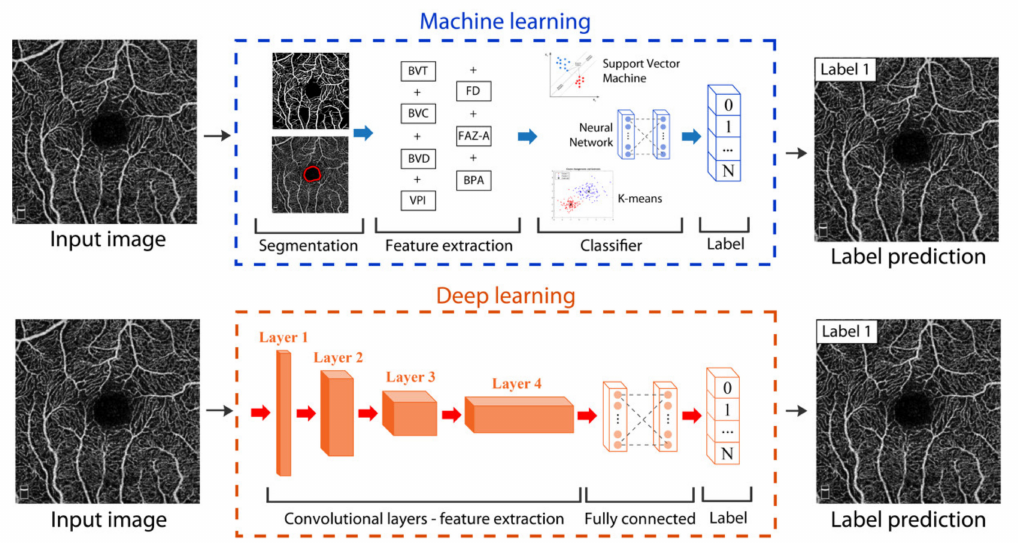
Figure 5. Examples of analyzed classification methods. OCTA image available from the open ROSE dataset